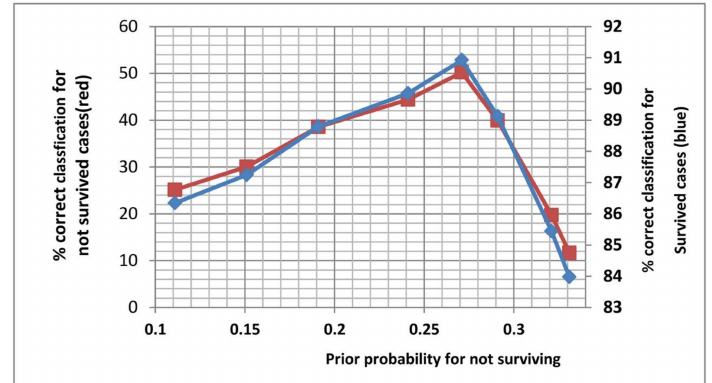
Figure 5. The relationship between the prior probability of not surviving and the associated percentage correct identification for the survived (blue plot) and not survived (red plot) cases. The subjects were from the calibration set. Only the section centered on the peak (i.e., prior probability = 0.27) is shown in this